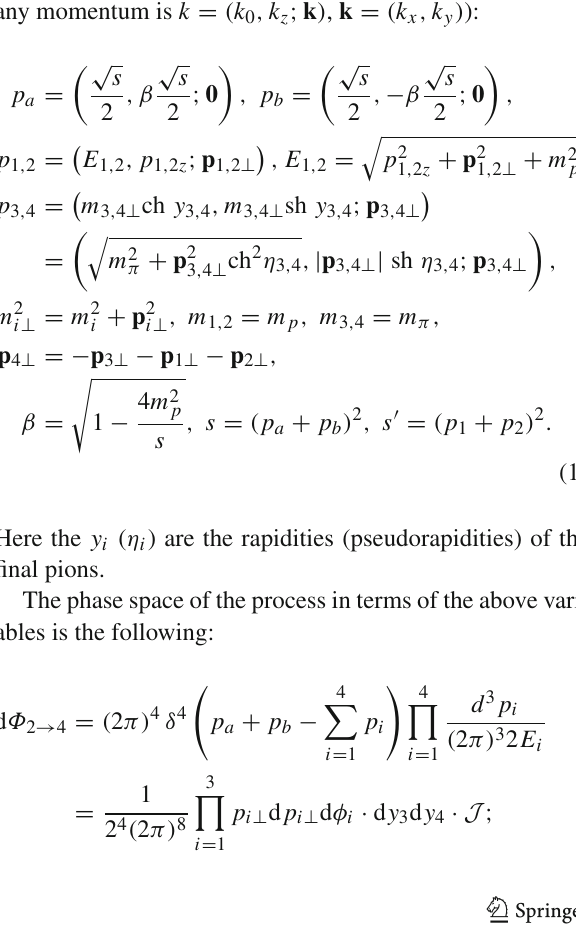
− q − p + q ) 2 , 1 ⊥ 1 3 2